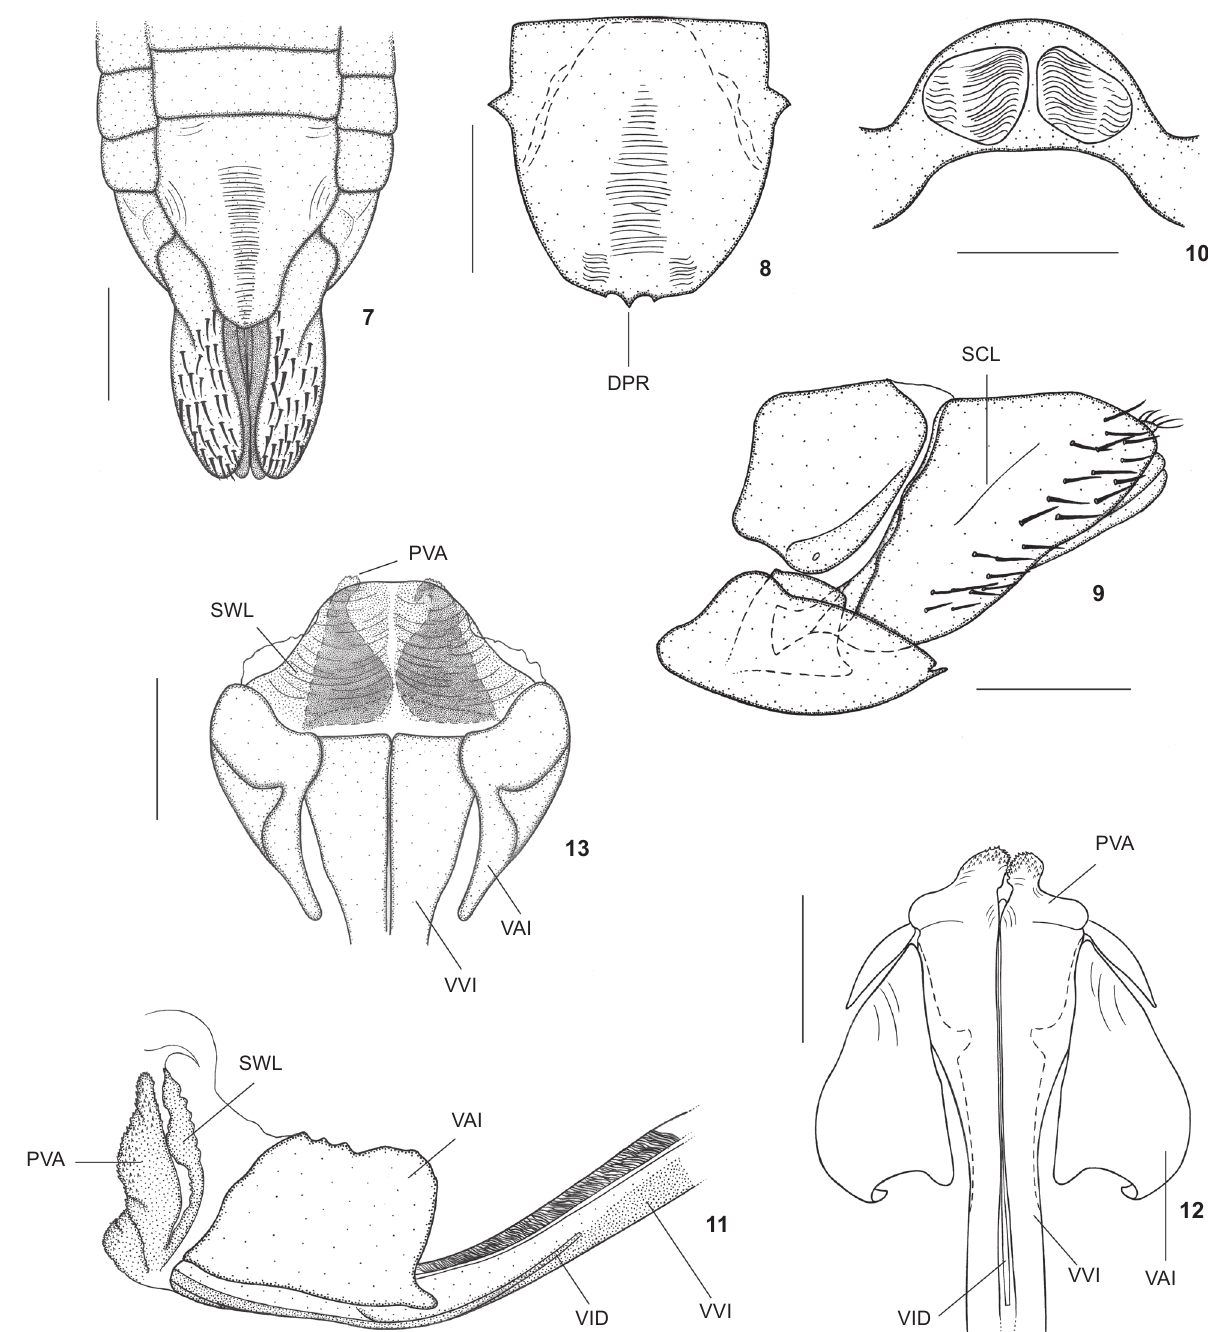
Figures 7-13. Scoposcartula frontaliana comb. nov. , female: (7) apical portion of abdomen, ventral view. S. talitae Leal, Mejdalani & Cavichioli, female: (8) sternite VII, ventral view; (9) apical portion of abdomen, lateral view; (10) internal sternite VIII, dorsal view; (11- 13) first valvifer, base of first ovipositor valvula, and associated structures in lateral (11), ventral (12), and caudal (13) views. (DPR) Dentiform projection, (PVA) prevalvifer area, (SCL) sclerotized line, (SWL) sclerotized wall, (VAI) valvifer I, (VID) ventral interlocking device, (VVI) valvula I. Scale bars: 7-10 = 1.0 mm, 11-13 = 0.5